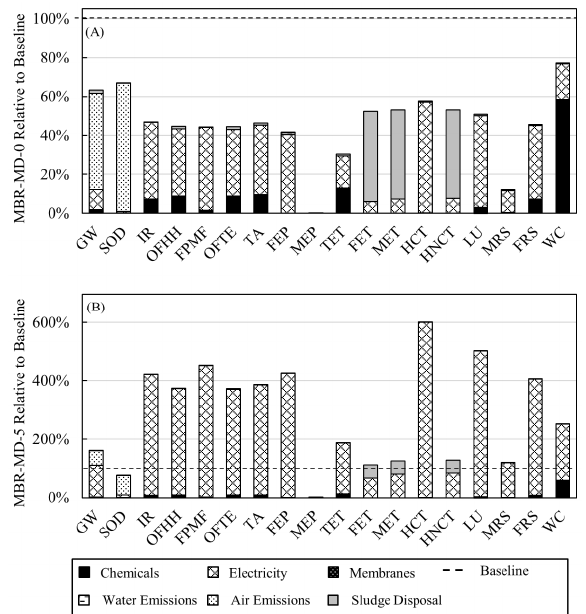
Figure 4. Percentage contributions to each category for the MBR-MD system scaled to the total Baseline impacts for ( A ) MBR-MD-0 (using all MD energy requirements satisfied with waste heat); or ( B ) MBR-MD-5 (grid electricity supplying 5% of the MD energy requirements with the remaining 95% of energy needs satisfied by waste heat). However, when grid electricity is used to supply a portion of the MD energy require- ments, environmental impacts increase substantially. Figure 4B shows the MBR-MD im- pacts relative to the Baseline when grid electricity supplies only 5% of the MD energy requirements (MBR-MD-5). HCT shows the largest increase in this regard with total im- pacts at 600% of the Baseline. SOD and MEP are the only impact categories to maintain a total environmental impact less than the Baseline at 61.7% and 0.30%, respectively. For the 5% grid energy configuration, SOD is the only impact category where electricity consump- tion is not the largest contributor. Six of the impact categories are examined in more detail for both systems (Figure 5). These six impact categories were selected because GW and SOD are valuable indicators for climate change; FEP and MEP are important categories for eutrophication often asso- ciated with wastewater effluents, and FET and MET were included due to the notable contribution of sludge waste on ecotoxicity. Environmental impacts for the MBR-MD-0 configuration were reduced by 31.0%, 44.8%, 50.9%, 99.9%, 43.2%, and 42.1% of the Base- line for the GW, SOD, FEP, MEP, FET, and MET, respectively.